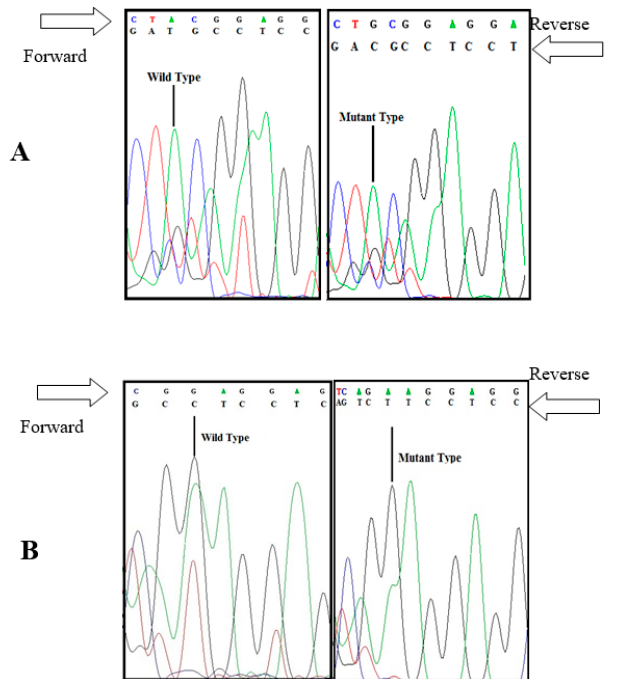
Figure 1. Detected mutations in exon 8 of BMPR1B gene of Markhoz goat breed. ( A ): Single nucleotide polymorphism 775A > G; ( B ) Single nucleotide polymorphism 777G > A.